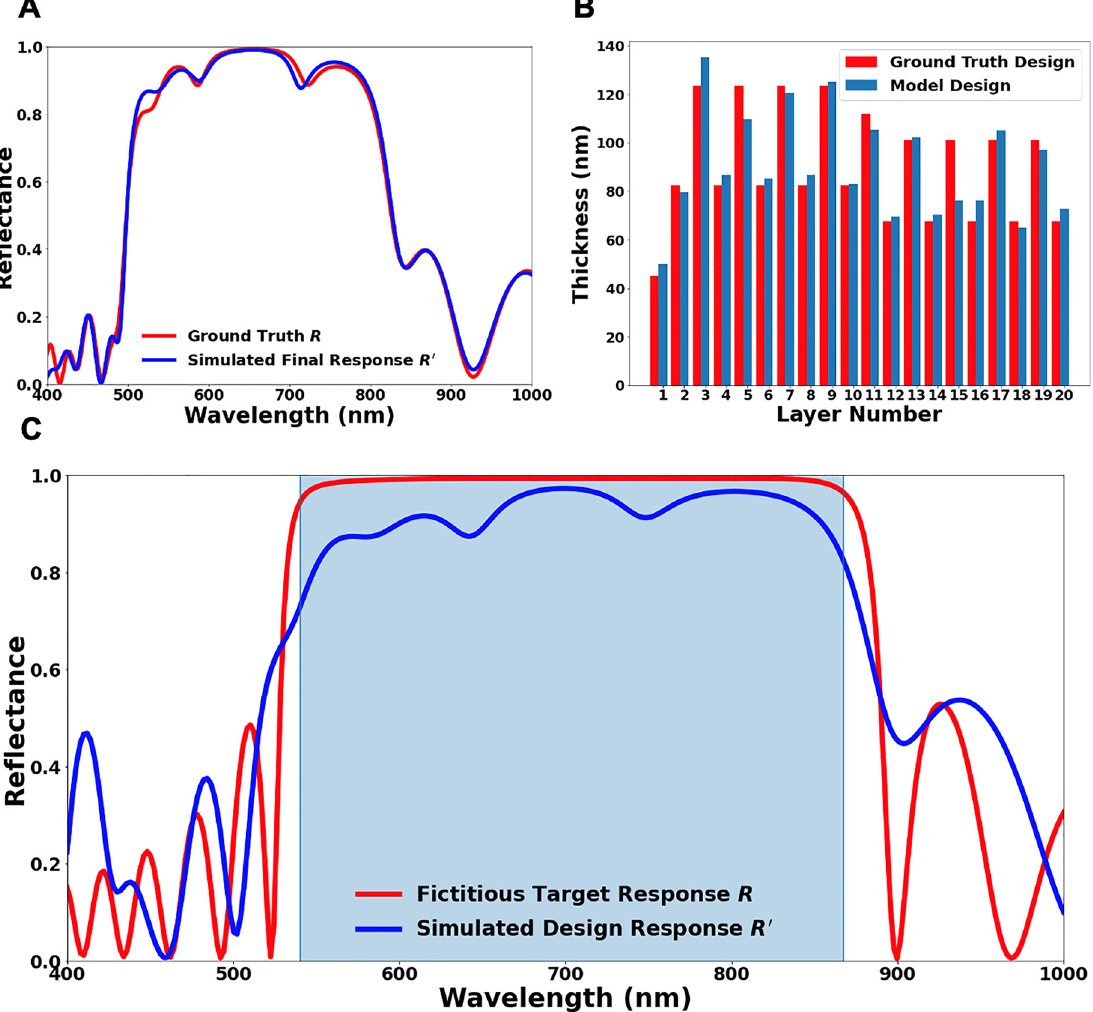
Figure 4: On-demand inverse design of thin-film high reflectors with extended high-reflectance zones. (A) Comparisonof a requested spectrum R and the simulated response R ′ of the design retrieved by the model. The target design is composed of two 9-layer periodic sub-stacks with a spacer layer in the middle and a cladding layer on the top, obtained with a known optimization strategy based on the principle of interference. (B) Comparison of design variables between the ground truth design and model-produced design. (C) Inverse design of a high re fl ector with ultrabroad high-re fl ectance zone. The requested spectrum R (red curve) is fi ctitious, taken froma20-layerDBRandarti fi ciallyextendedinthehigh-re fl ectanceregionforabandwidthnotachievablebyknowndesignmethodsbasedon physical principles. The blue curve shows the simulated response R ′ of the design suggested by the tandem optimization model. Note that in this case, optimization is applied to the high-re fl ectance region only, as highlighted by the shaded